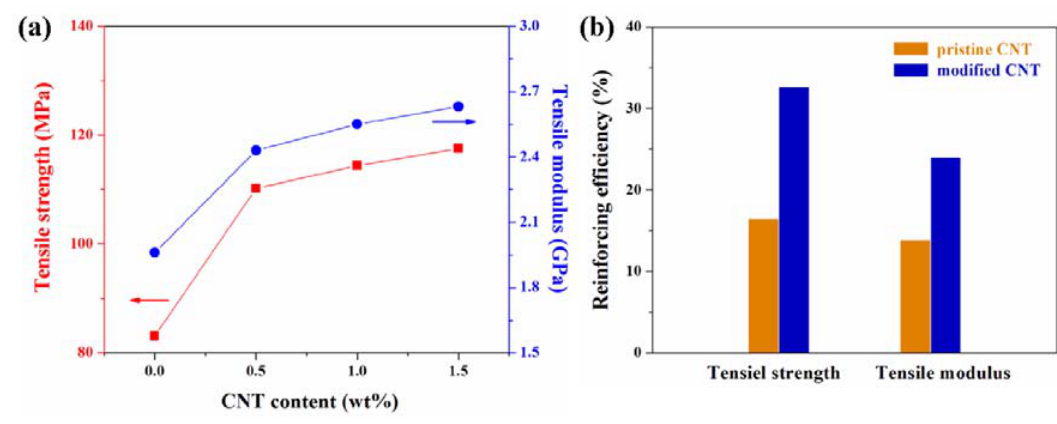
Figure 6. (a) Mechanical properties of TLCP nanocomposites with the CNT content. (b) Reinforcing efficiency of pristine and modified CNTs on mechanical properties of TLCP nanocomposites containing 0.5 wt% of CNT content. Reinforcing efficiency (%) = [( M M )/ M ] × 100, where M and M represent the mechanical properties, such as m m c m